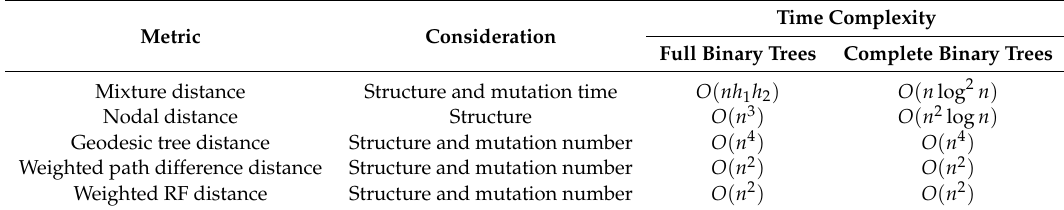
Table 3. Comparison of metrics for binary